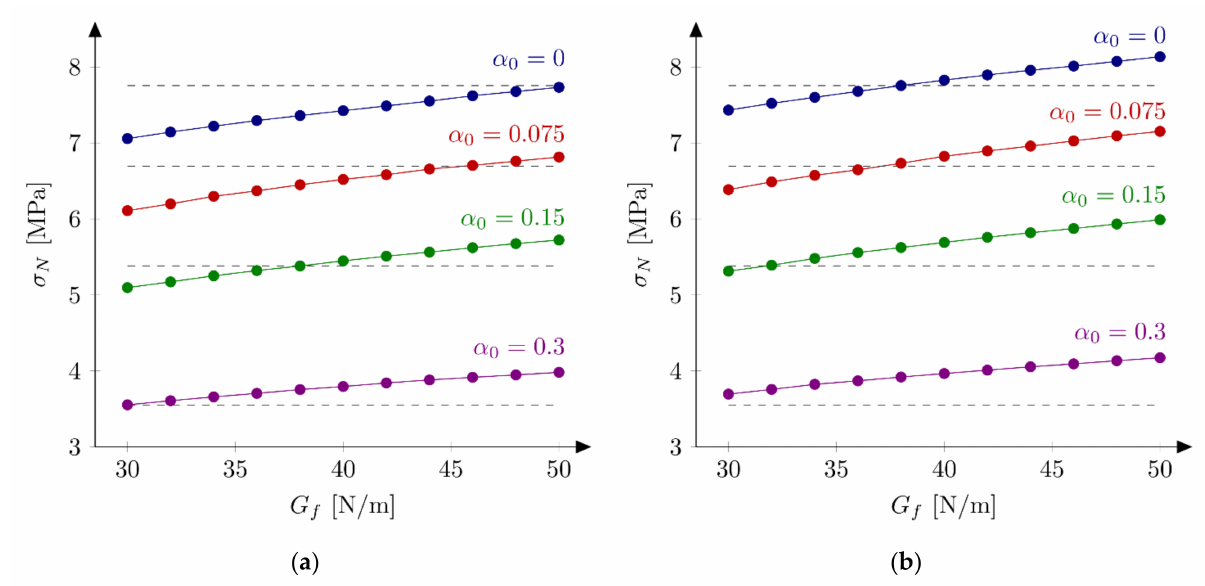
Figure 6. Nominal strengths σ FEM for the small beam, different initial fracture energies and the N tensile strength: ( a ) f t = 4.8 MPa; ( b ) f t = 5.2